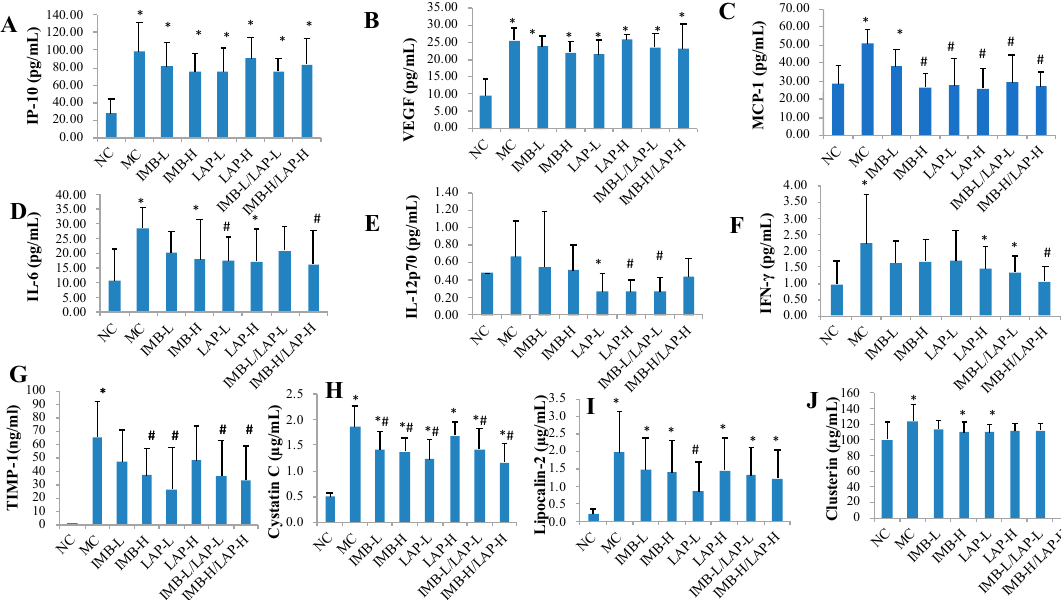
Figure 3. E ff ects of IMB and LAP supplements on circulating levels of cytokines and kidney injury Figure 3. Effects of IMB and LAP supplements on circulating levels of cytokines and kidney biomarkers. The circulating cytokines levels of IP-10 ( A ), VEGF ( B ), MCP-1 ( C ), IL-6 ( D ), IL-12p70 injury biomarkers. The circulating cytokines levels of IP-10 (A), VEGF (B), MCP-1 (C), IL-6 (D), IL- ( E ) and IFN- γ ( F ); the circulating levels of kidney injury markers TIMP-1 ( G ), cystatin ( H ), lipocalin-2 12p70 (E) and IFN- γ (F); the circulating levels of kidney injury markers TIMP-1 (G), cystatin (H), ( I ) and clusterin ( J ). Values are expressed as Mean ± SD, n = 8. Within each panel, values with the lipocalin-2 (I) and clusterin (J). Values are expressed as Mean±SD, n=8. Within each panel, values with superscript symbols “*” and “#” are significantly di ff erent from the NC and MC, respectively, p at least <